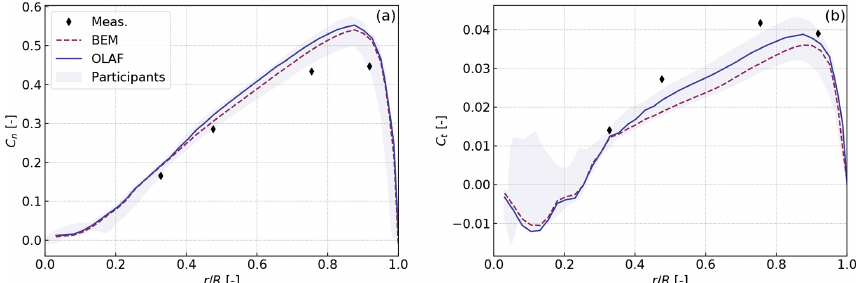
Figure 5. Simulation of a HAWT using the AeroDyn driver. Results for test case IV.1.2 (constant, uniform inflow) of IEA Task 29. Normal and tangential force coefficients along the blade span ( respectively a and b)